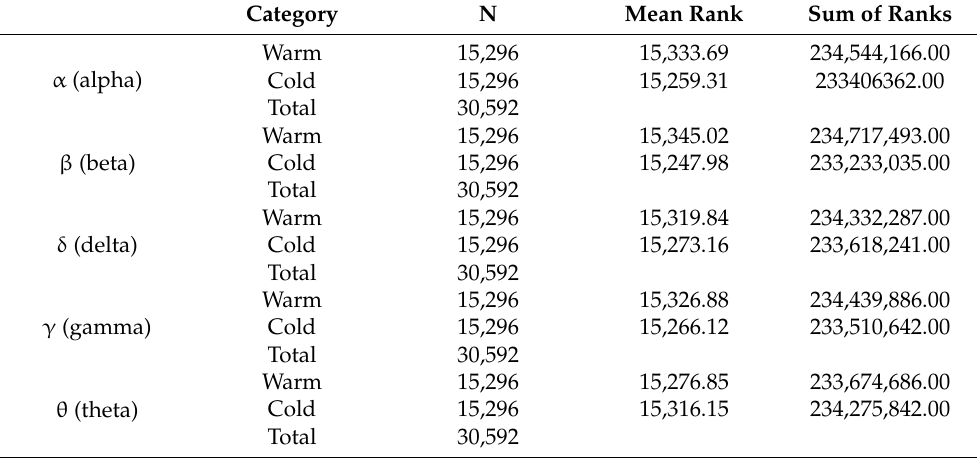
Table A3. Ranks of the mean band measurements related to the Warm and Cold categories for the Colour VDEP.